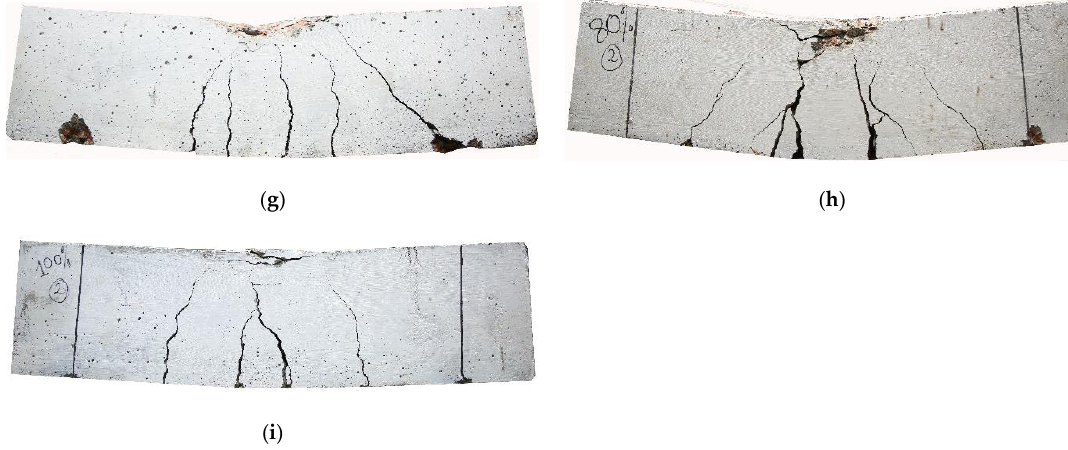
Figure 9. Images of the beams after failure in flexural load: ( a ) Control (0% IFSSA), ( b ) 10% IFSSA, ( c ) 20% IFSSA, ( d ) 30% IFSSA, ( e ) 40% IFSSA, ( f ) 50% IFSSA, ( g ) 60% IFSSA, ( h ) 80% IFSSA, ( i ) 100% IFSSA.